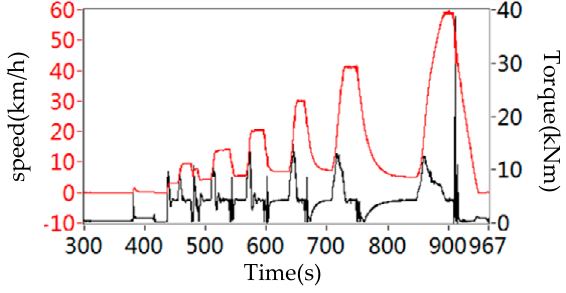
Figure 31. Acceleration test. Table 2. Acceleration test.